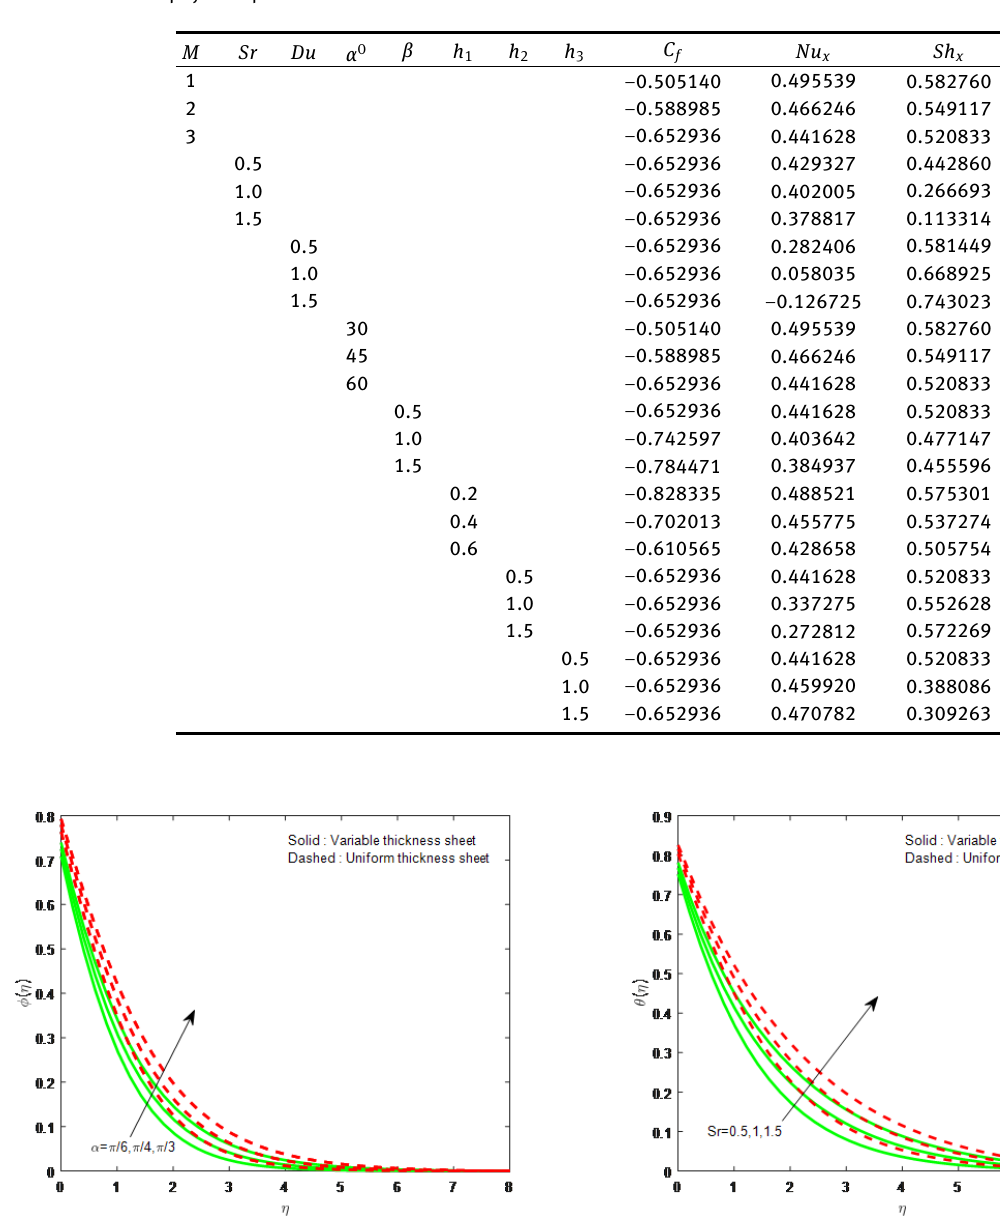
Fig. 8: Influence of Sr on temperature